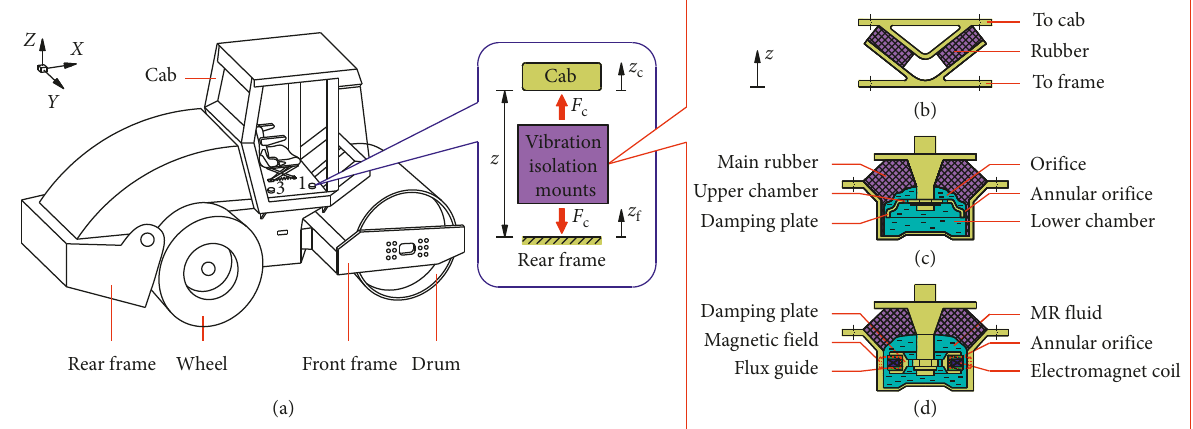
Figure 1: Schematic of vibratory roller with different cab’s isolation mounts. (a) Single drum vibratory roller. (b) Passive rubber mount. (c) Passive hydraulic mount. (d) Semi-active hydraulic mount.